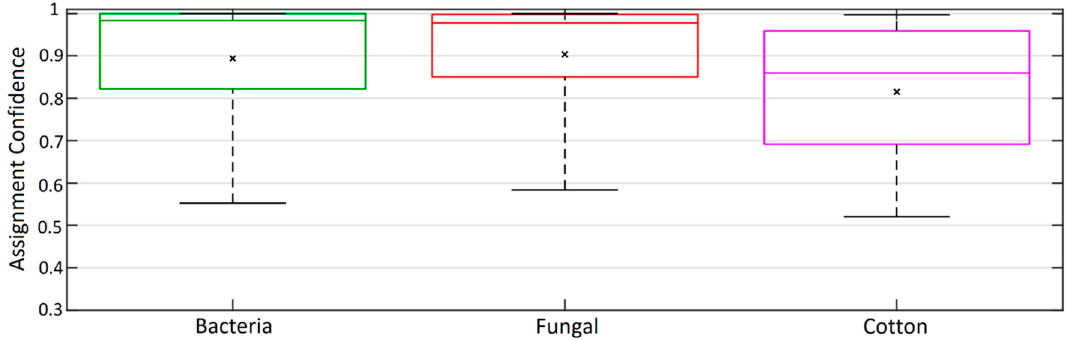
Figure 4. Box and whisker plots of the GBA model prediction class assignment confidence applied to the University Place ambient MBS data. Whiskers denote the 5th and 95th percentiles. Cross denotes mean value.